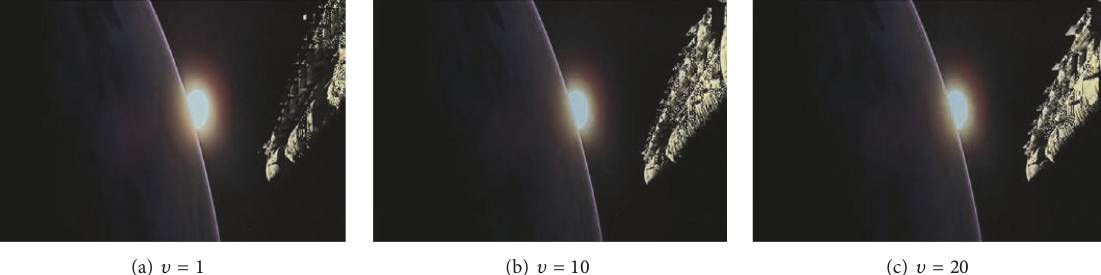
Figure 13: Target trajectory display of sequence